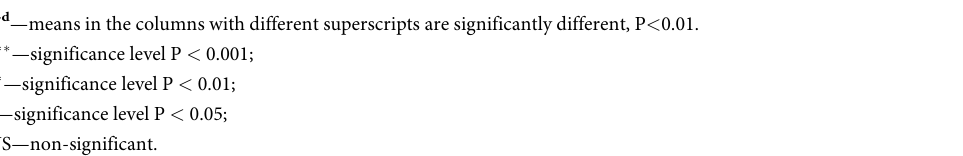
fer significantly) as in the slow method. Therefore, these changes were not presented in Table 2. In turn, the pH values of ES meat of heifers, cows, and bulls were insignificantly